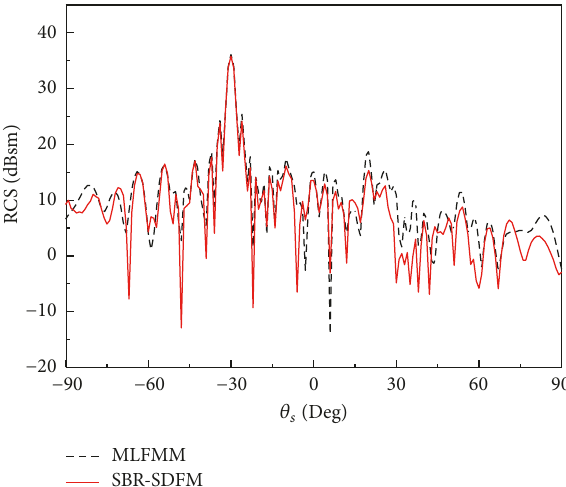
Figure 12: Bistatic RCS for a sphere above sea surface.